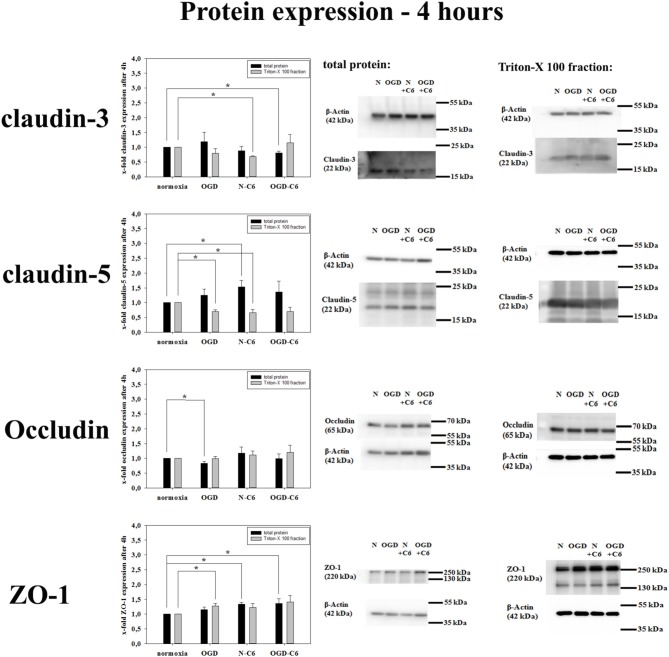
Influence of 4 h oxygen/glucose deprivation (OGD) treatment and presence of astrocyte soluble factors on protein expression of tight junction proteins claudin-3, claudin-5, occluding, and ZO-1 of cerebEND cells. On the left side results of densitometric analysis derived from western blots of total protein cell lysates as well as of Triton-X 100 membrane enriched fractions are presented, on the right side according representative western blot images are depicted. N, cerebEND normoxic control; OGD, cerebENDs treated under OGD conditions for 4 h; N−C6 or N+C6, cerebENDs treated for 4 h with C6 conditioned medium derived from C6 cells which were treated under normoxic control conditions for 4 h; OGD−C6 or OGD+C6, cerebENDs treated for 4 h OGD with C6 conditioned medium derived from C6 cells which were treated under OGD conditions for 4 h. Statistical significance was labeled with *(p < 0.05, two-sided student's t-test with same variances). Data are presented as means ± s.e.m. (n = 4–6).